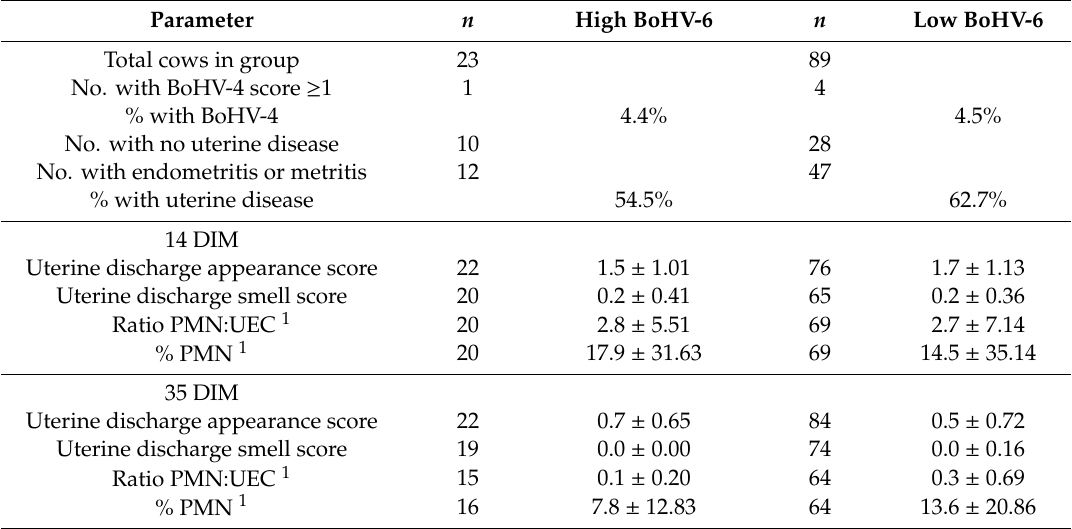
Table 4. Summary evidence for associations with BoHV-4 and uterine disease in early lactation in cows with high ( > 200) or low (1–200) BoHV-6